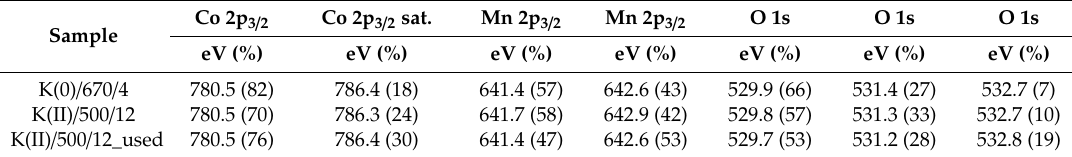
Table 7. Binding energies and relative percentage (in parentheses) of fitted